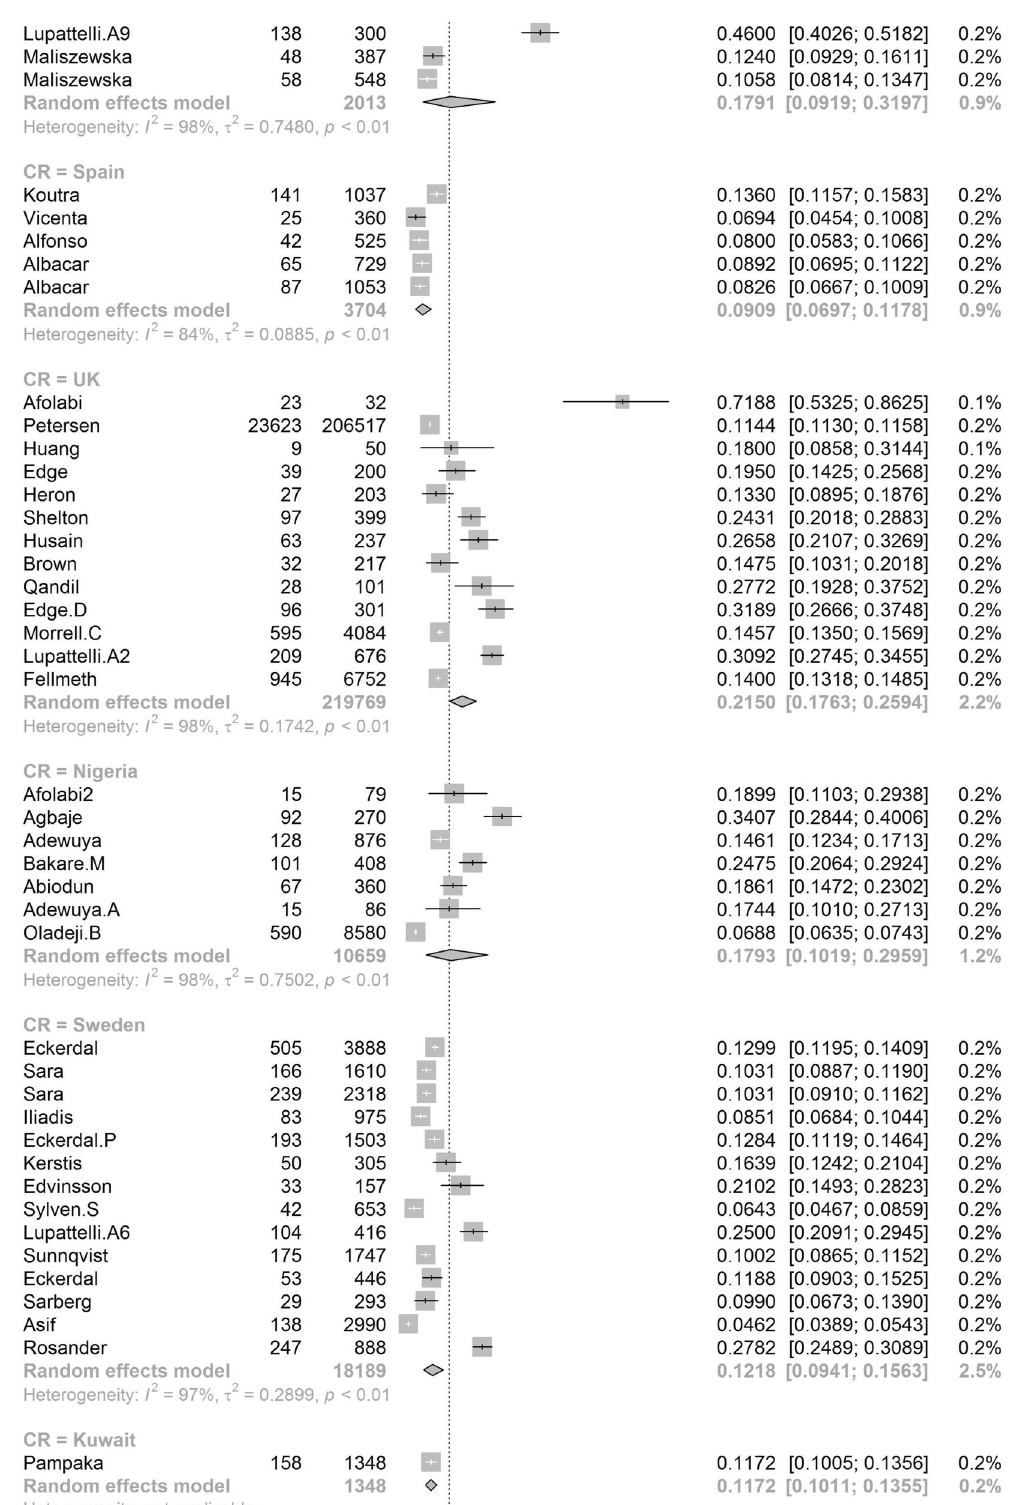
infant ’ s gender is not related to postpartum depression. Although female infant sex is favorably linked to PPD, according to research conducted in Asia (China, India), Africa (Nigeria), and Turkey, with qualitative research suggesting a role for male gender